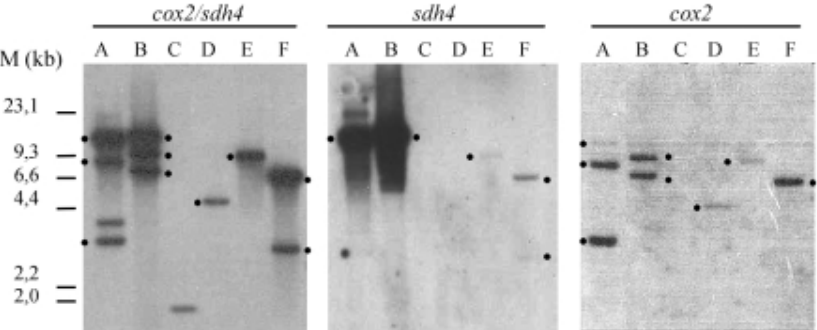
Figure 1 - Hybridizations between mtDNA from some plant species and cox2/sdh4 , sdh4 and cox2 probes (indicated at the top of the autoradiographs). Legends:A=potato,B=cauliflower,C=maize,D=coix,E=soybean,F=pea,M=molecularsizemarkers( (cid:2) Hind III/ (cid:3) x Hae III).Theblackpointsindi- cate bands of the same size.